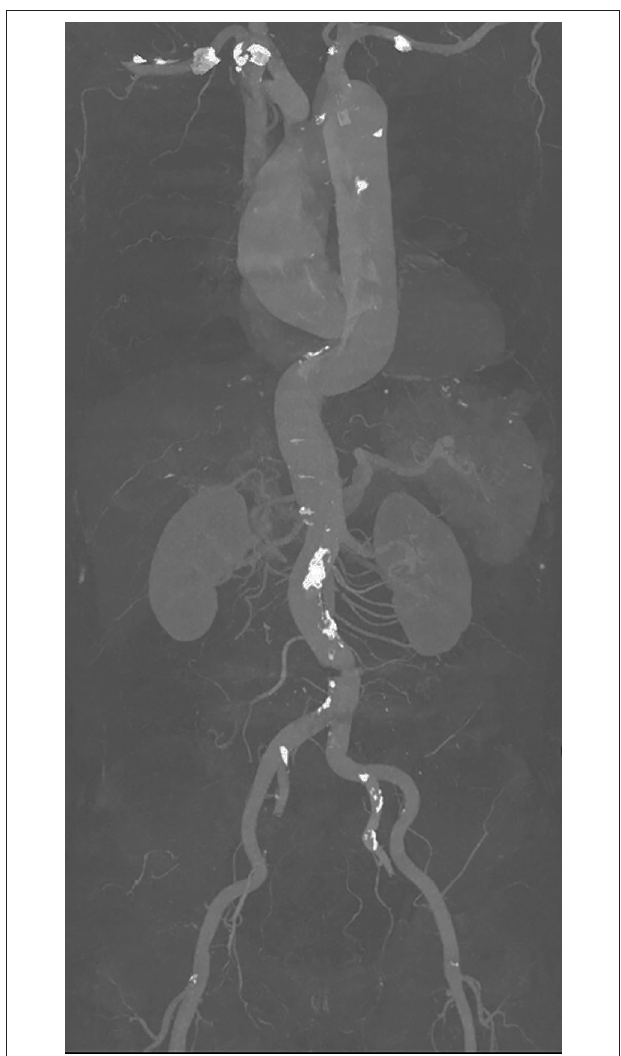
FIGURE 3 | Aortic